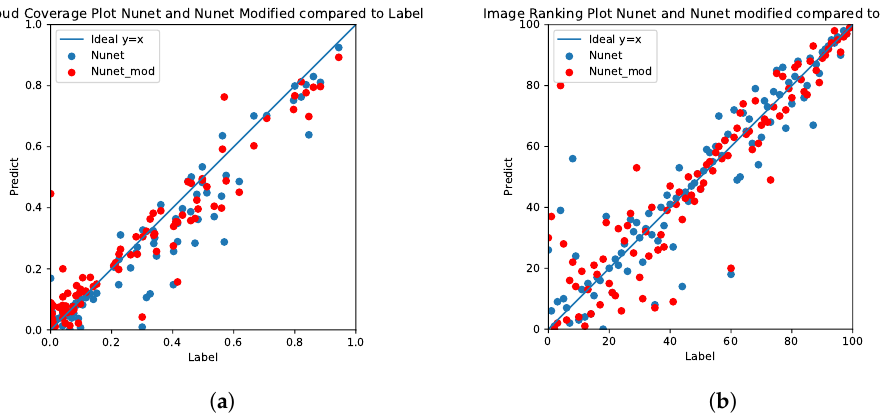
Figure 3. Comparison of predicted output by NU-Net and NU-Net-mod against the expected result of image labels. ( a ) cloud coverage; ( b ) rank.